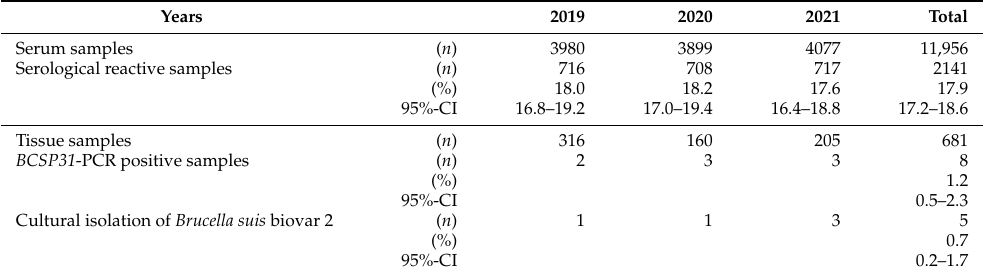
Table 1. Wild boar samples and results included in the monitoring of porcine